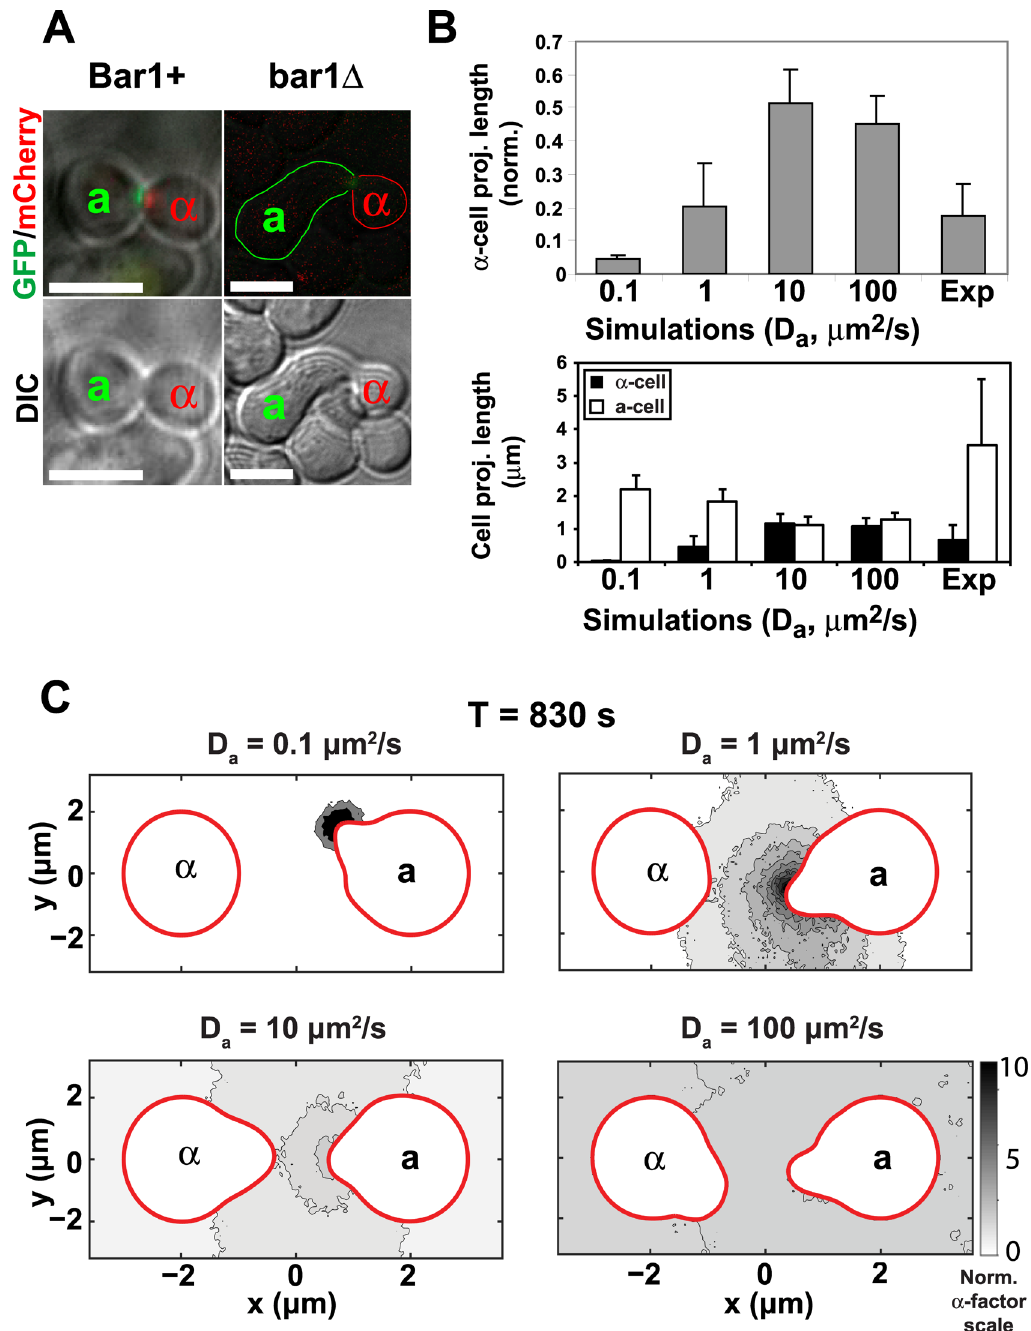
Fig 9. Estimating the diffusion constant of a-factor. (A) Projection lengths in bar1 Δ versus Bar1+ a -cells. In the presence of Bar1, we only observed short-range matings in which both a -cells and α -cells possessed short projections. In the absence of Bar1 (bar1 Δ matings), we observed longer projections made by the bar1 Δ a -cells, whereas the α -cell projections remained short. The top two panels are fluorescent images of Spa2-GFP ( a -cell) and Spa2-mCherry ( α -cell) showing the adjacent/overlapping polarisomes indicating a successful mating. The bottom two panels are DIC images that depict the projection morphologies of the mating cells. Scale bars = 5 μ m. (B) The relative projection lengths of α -cells versus a -cells in simulations compared to experiments. In the top bar graph, the α -cell projection length is presented as the fraction of the sum of the two projection lengths ( n = 25 matings for Exp.); the average and standard deviation (error bars) are shown. The two-cell simulations with noise were performed as described in Fig 2 for varying α -factor diffusion values: D a = 0.1, 1, 10, and 100 μ m 2 /s. The average and